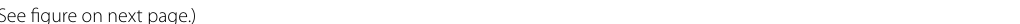
Table 2 Hysteresis parameters ( B No Sample Weight